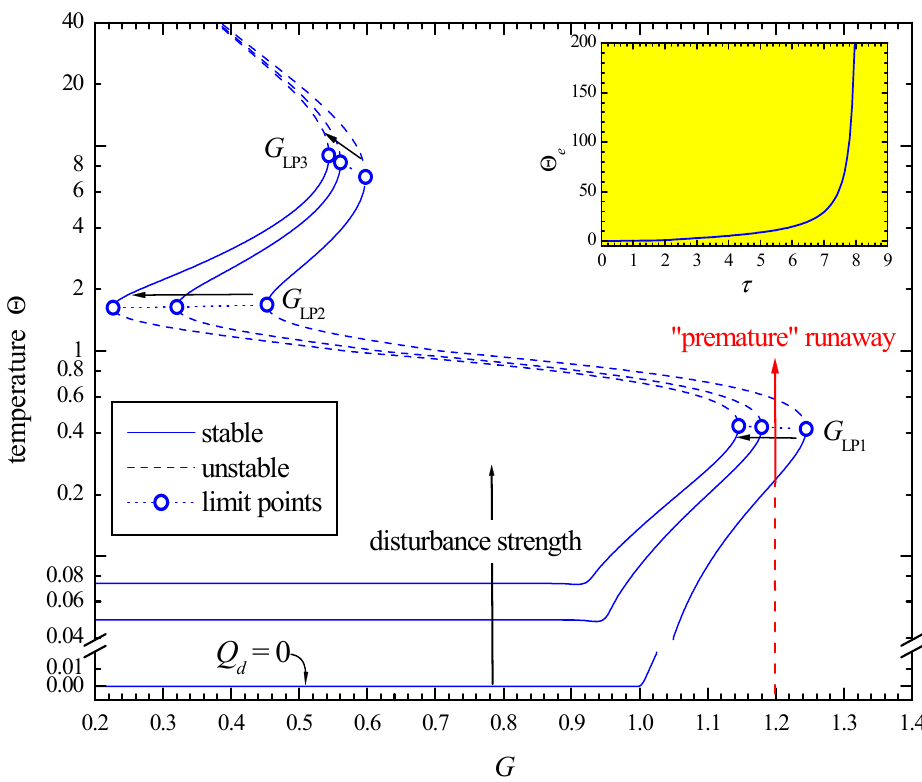
Figure 16. Effect of disturbances on the limit points and “premature” runaway explanation.